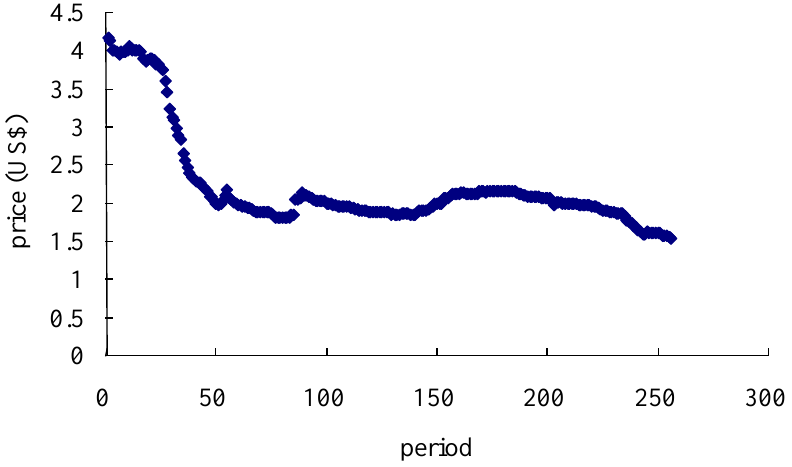
Figure 1. The collected dynamic random access memory (DRAM) price